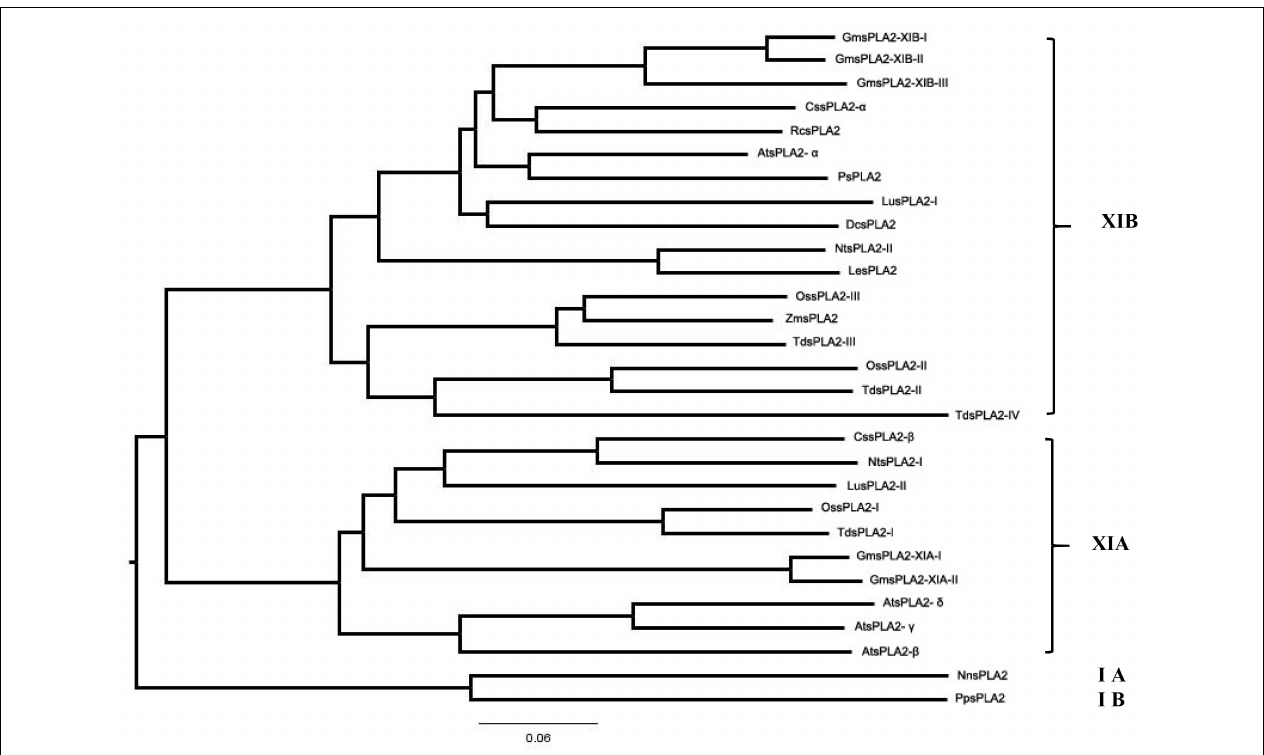
FIGURE 4 | Phylogenetic tree of the deduced amino acid sequences of all reported plant sPLA 2 s. The program used to perform the sequence alignment was Clustal X (version 2.0) and to produce phylogenetic analysis the phylogenetic tree generation methods from the ClustalW2 package was used (on line tool http://www.ebi.ac.uk/Tools/phylogeny/clustalw2_phylogeny/). To draw the tree we used the Figtree v.1.4.4 program (http://tree.bio.ed.ac.uk/software/figtree/). The accession numbers of sPLA 2 indicated in this figure are provided as Supplementary Appendix S1